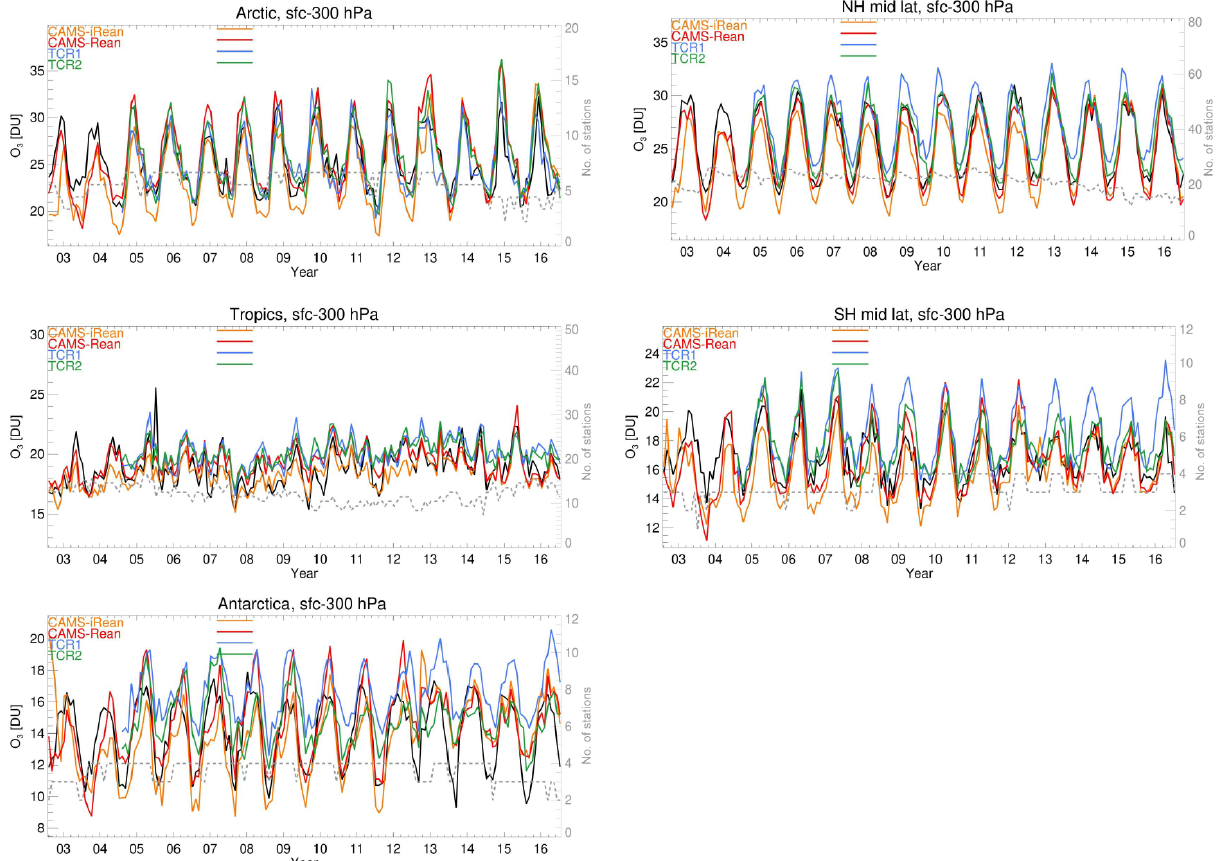
Figure 4. Evaluation of zonally averaged monthly-mean partial columns (surface to 300hPa) against sonde observations. Observations are in black. The dashed grey line refers to the number of stations that contributes to the statistics (right vertical axis).